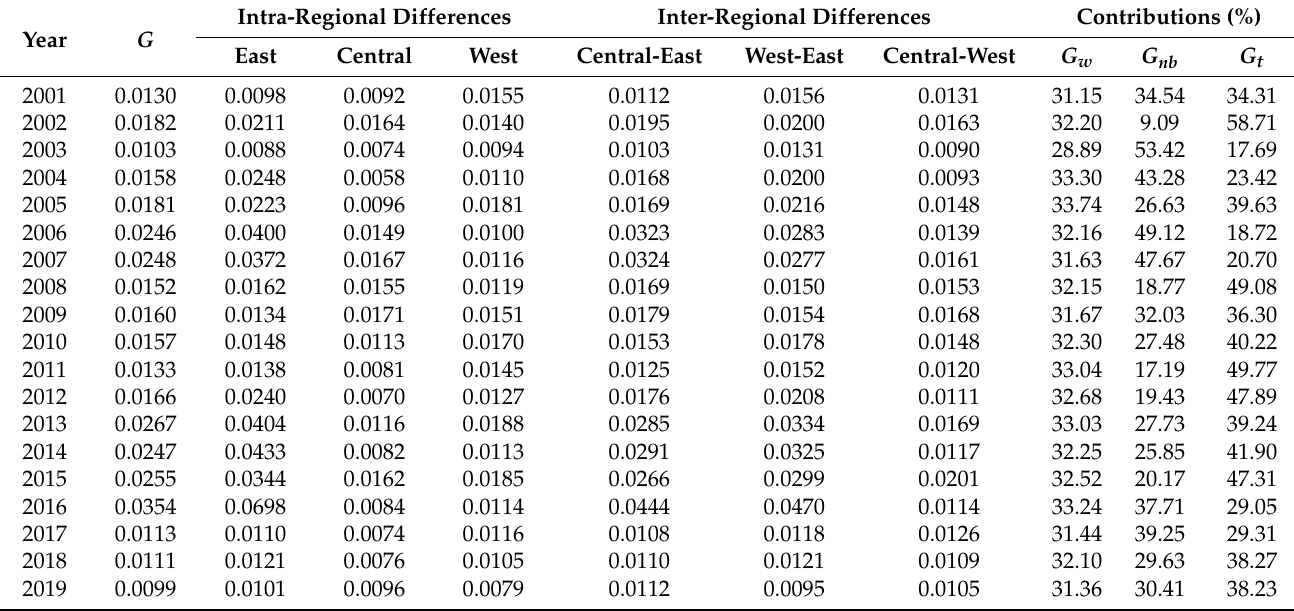
Table 3. The Dagum Gini coefficient and its decomposition of